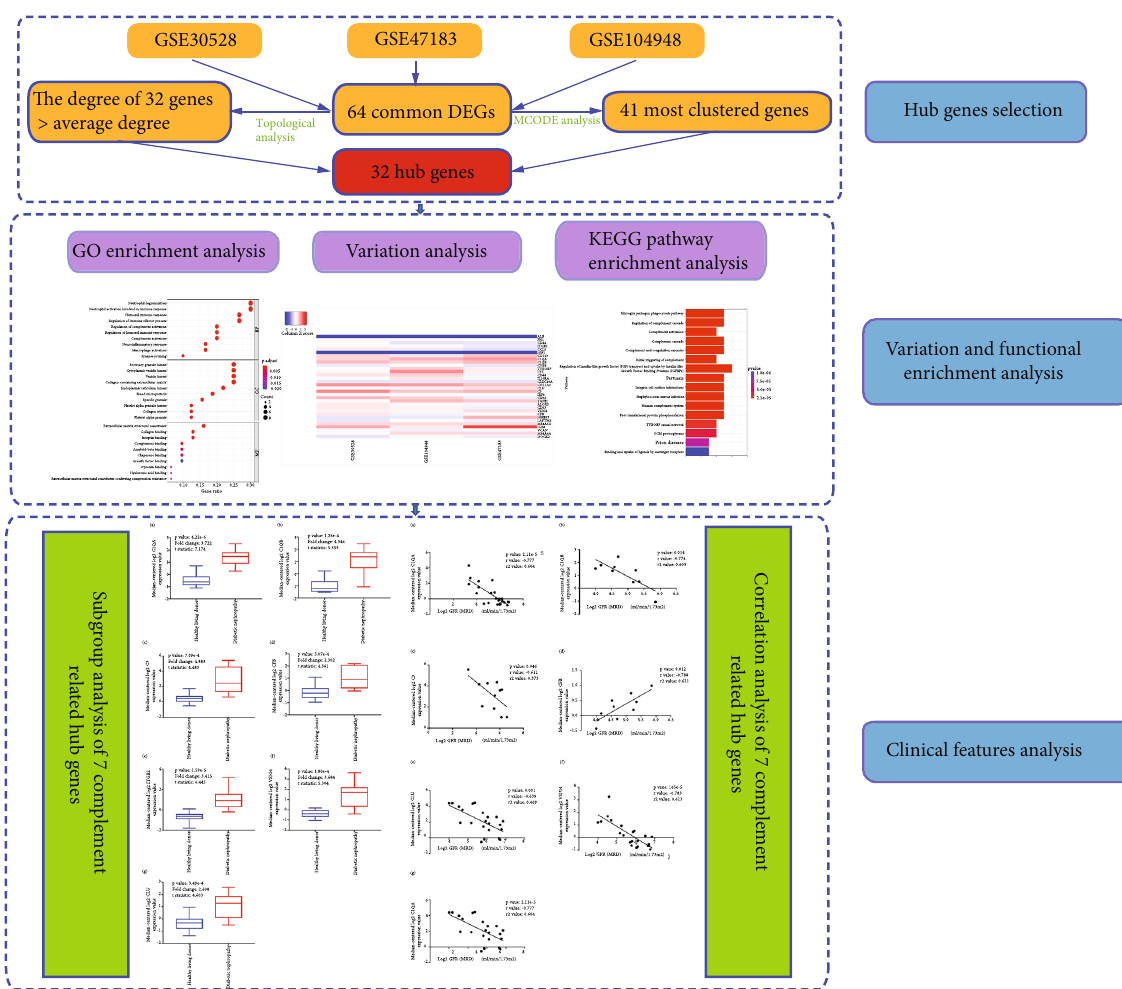
Figure 1: A fl ow chart based on an integration strategy of multiple-microarray